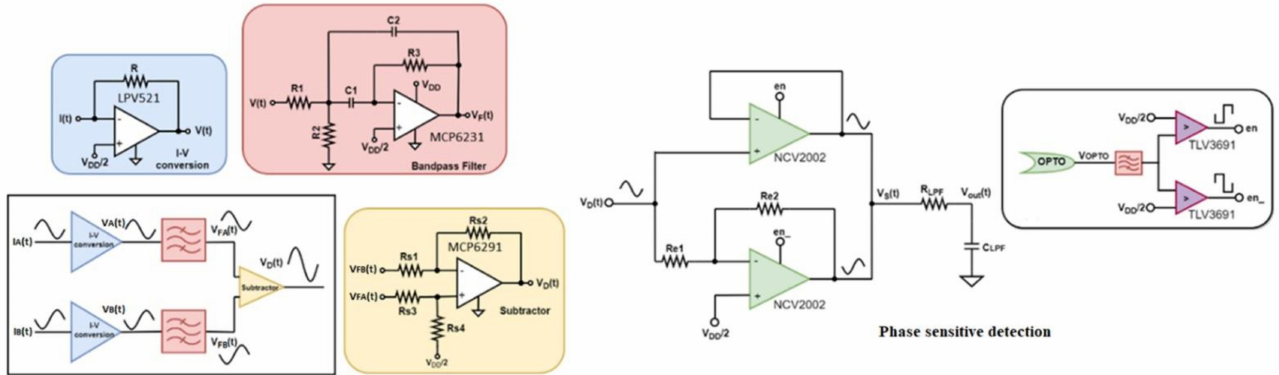
Figure 5. Design of the sensor